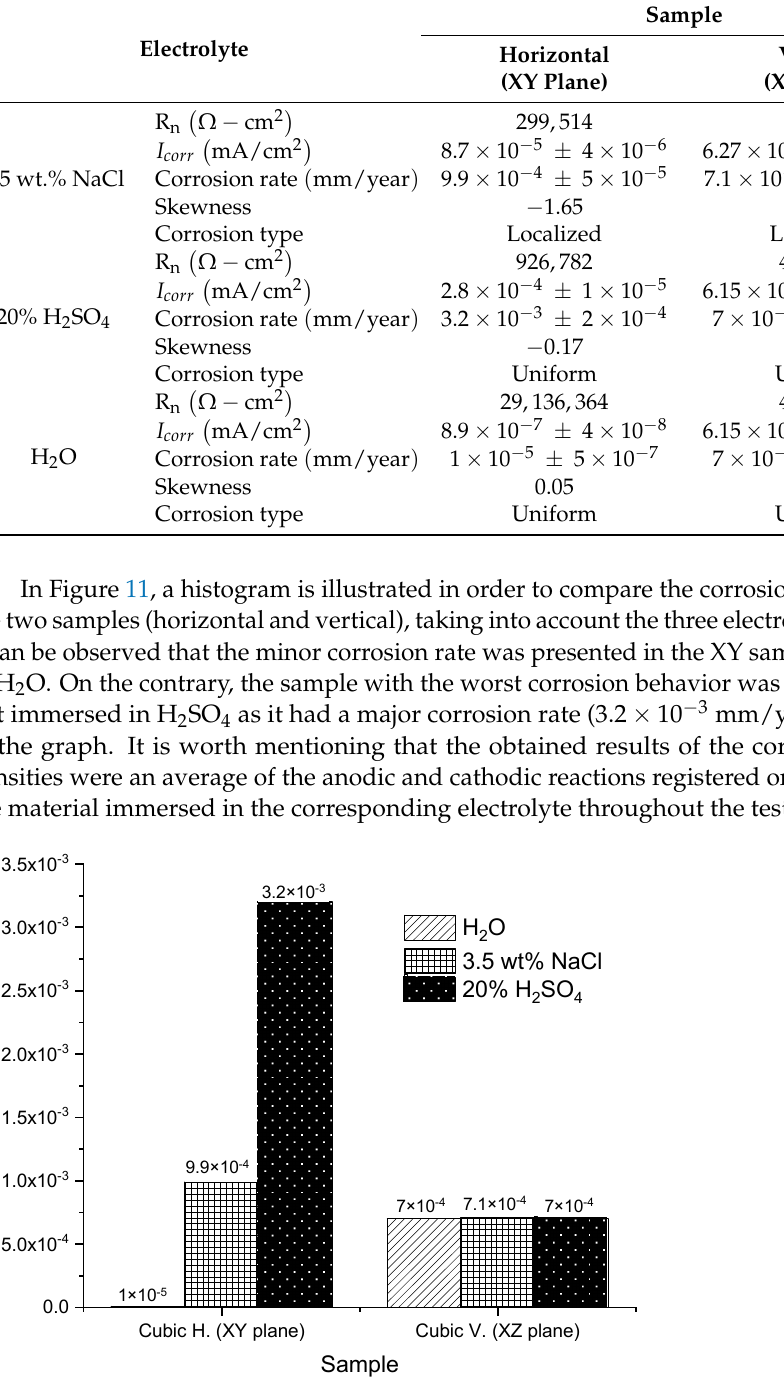
Figure 11. Comparison of the corrosion rate between the samples in the three electrolytes. The number of points for each corrosion test was 1024 points at a rate of 1 point per second. The average corrosion rate for each performed test is shown.